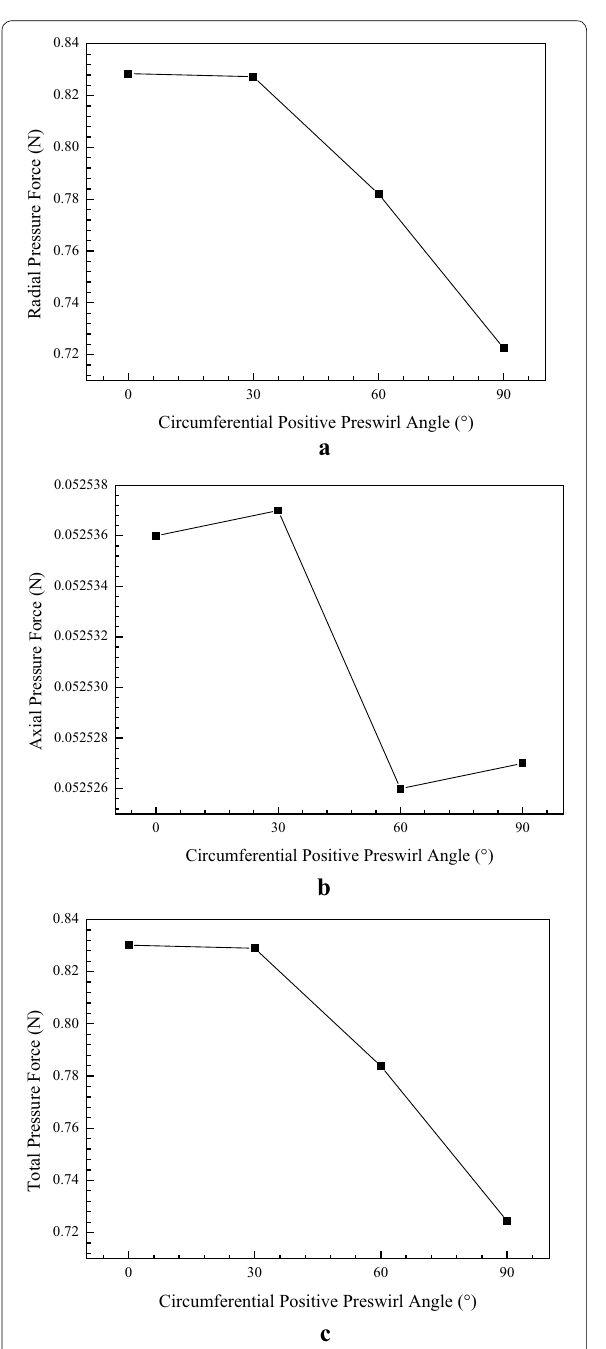
Figure 12 Pressure forces versus circumferential positive pre-swirl angle: a radial pressure force, b axial pressure force, and c total pressure force